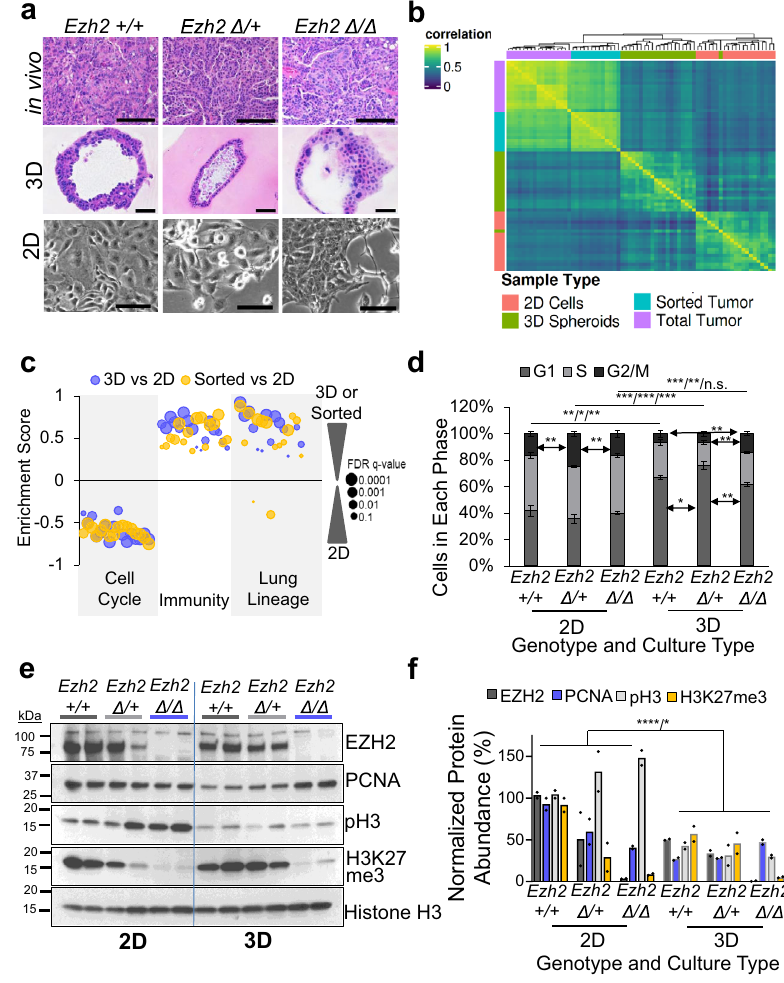
Fig. 2 | Model systems differ in cell cycleand gene expression. a Representative imagesofinvivotumorhistology,invitro3Dtumorspheroidhistologyand2Dcell cultures of the indicated Ezh2 genotypes, scale bar=100 µ m. n =3 or greater indi- vidualmousetumor-derivedcultureswereexaminedforeachgenotypeandculture system. b Heatmap of sample-to-sample correlations using highest loading genes from PC3 analysis, where the Pearson correlations are weighted by sample-sample information and sample-sample consistency (see “ Methods ” ). The 1 − correlation value was then used as a pseudo distance for hierarchical clustering and ordered usingdefaultargumentofdendsort. n =17,13,20,21fortotaltumor,sortedtumor, 2D cell cultures, 3D tumoroid individual mouse tumor-derived samples, respec- tively. c Rank-ordered gene lists were queried against the MSigDB databases and enrichment scores of selected gene signatures for2D, 3D, or in vivo sorted tumors were plotted. Dot size re fl ect FDR estimates. Data are shown in Supplementary Table3. d Percentagesof cellsineachcellcyclephaseweremeasured by7AADcell